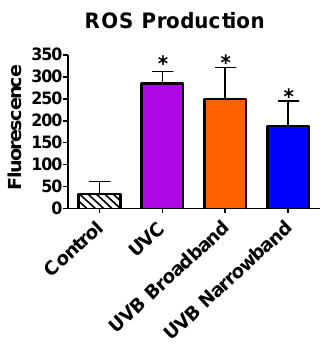
Figure 6. Oxidative stress following 1 h of UV light exposure of CHO10B2 cells. Error bars indicate standard error of the mean of at least three independent experiments. * Indicates statistically significant differences compared to control ( p < 0.05), one-way ANOVA followed by Turkey’s Multiple Comparison Test.